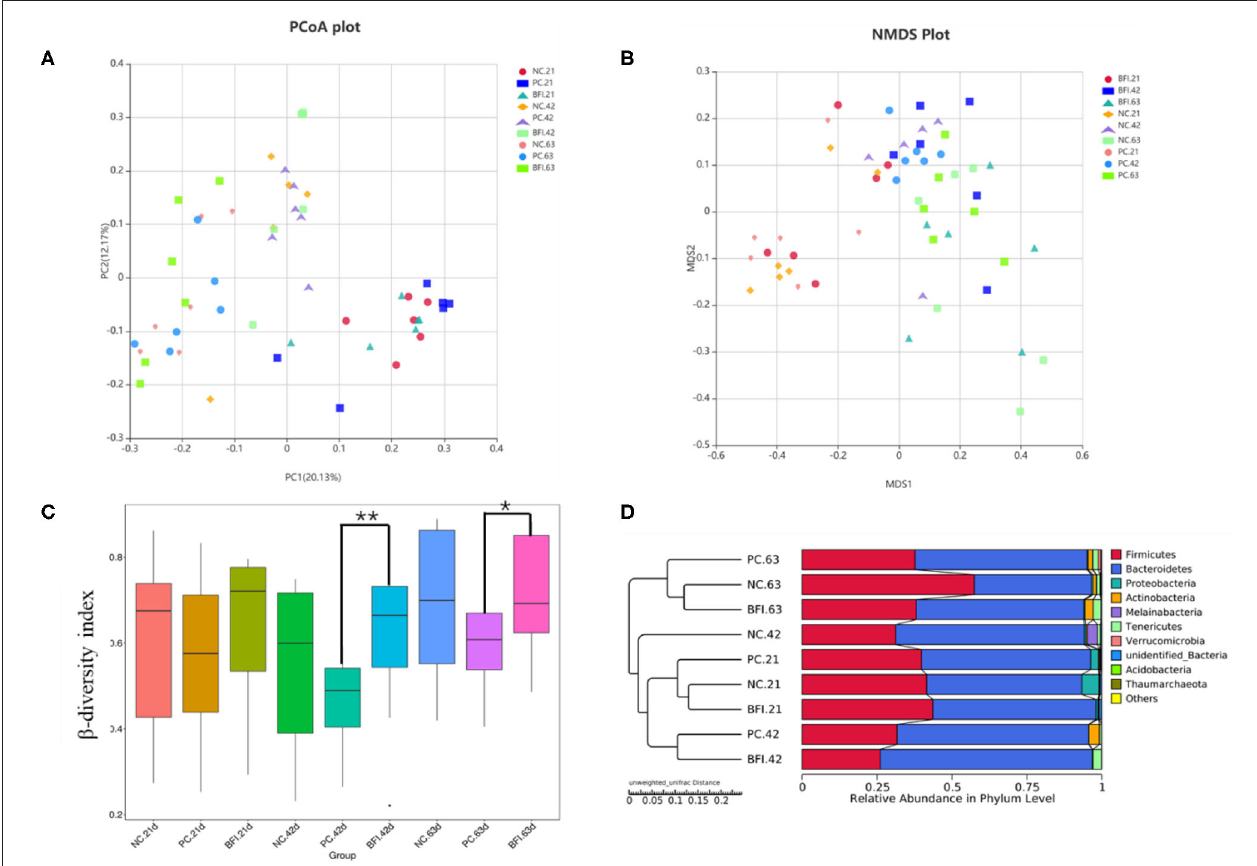
FIGURE 2 | Effect of dietary compound probiotics on the β -diversity of cecel microbiota in yellow-feathered broilers. (A) PCoA plot. (B) NMDS plot. (C) β -diversity index. (D) UPGMA clustering was conducted based on unweighted unifrac distance. NC, negative control without in-feed antibiotics. PC, positive control with in-feed antibiotics with 200 mg/kg of oxytetracycline calcium + 250 mg/kg of nasiheptide. BFI, compound probiotics consisting of heat-inactivated Bacillus subtilis and Lactobacillus acidophilus BFI. * P < 0.05 and ** P <